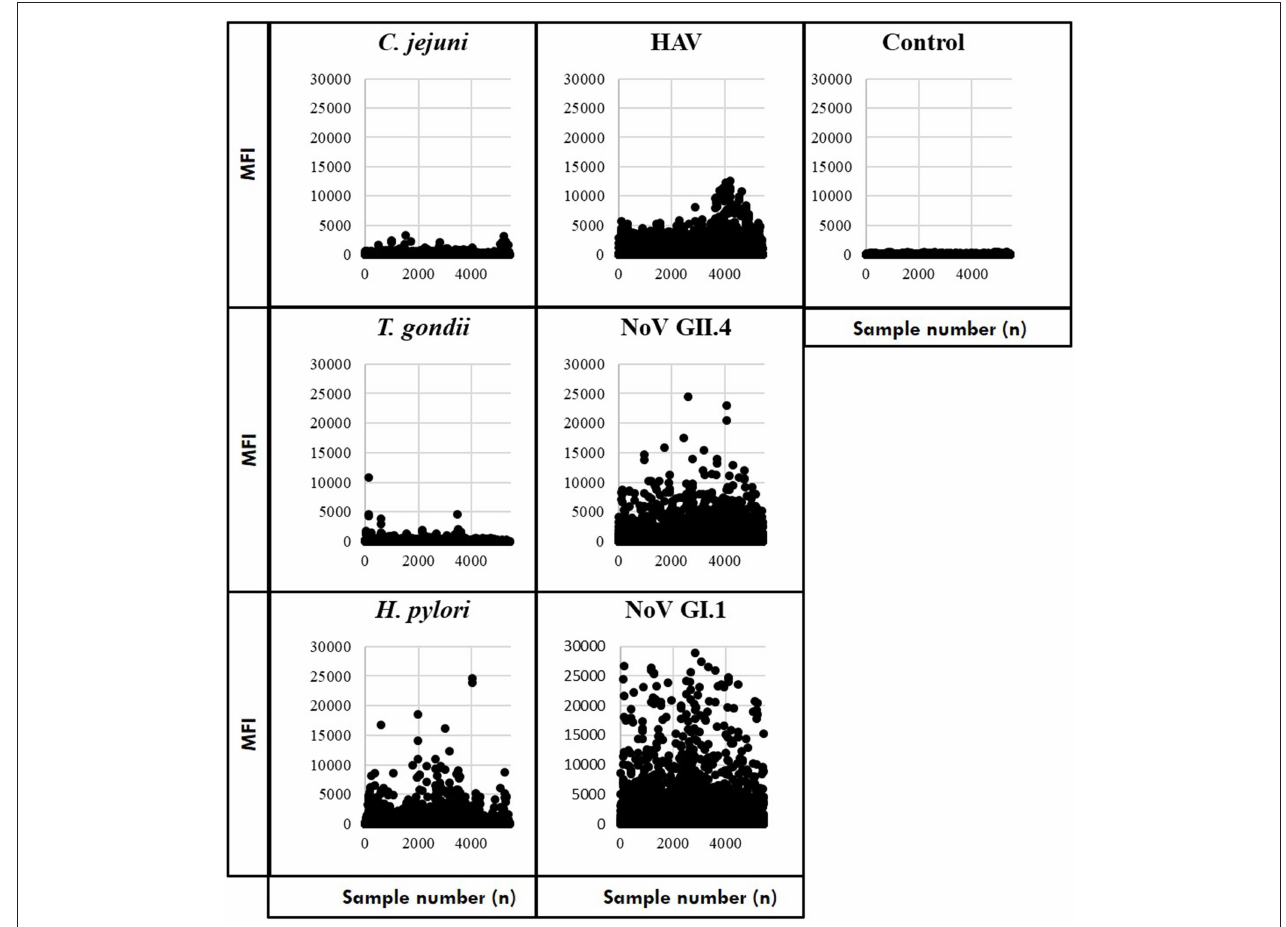
FIGURE 1 | Median fluorescence intensity (MFI) for the target pathogens and assay